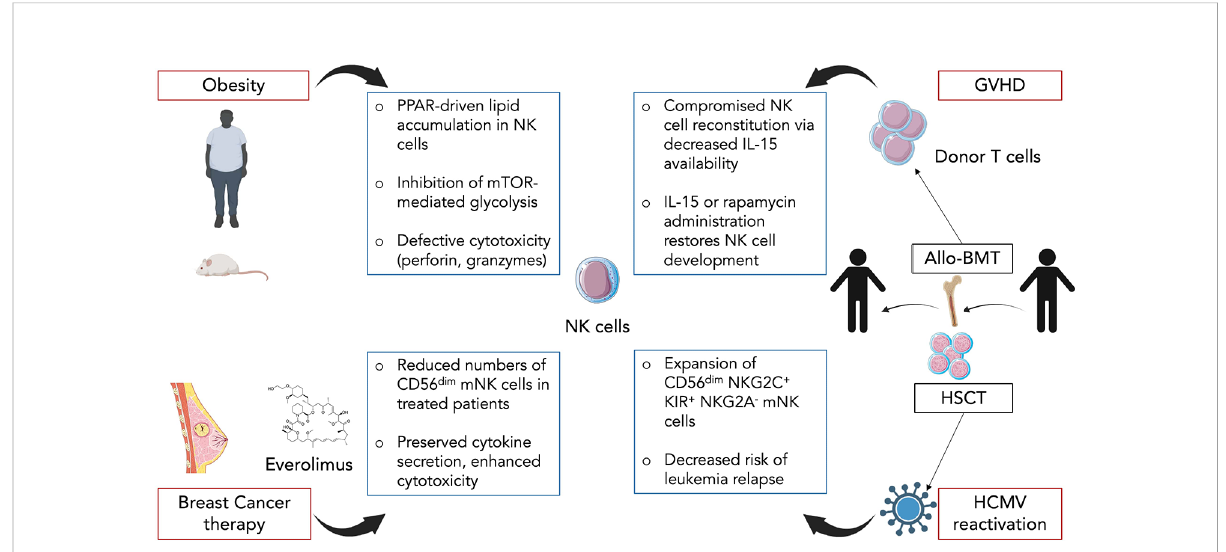
FIGURE 3 Impact of diverse in fl ammatory contexts on NK cell maturation and functional response. In obesity, circulating NK cells accumulate lipid droplets through a PPAR-driven mechanism. This directly promotes an inhibition of mTOR-mediated glycolysis as well as decreased cytotoxic capacity. In breast cancer therapy, mTOR inhibitor everolimus is commonly used and induces changes in NK cells. Treated patients display reduced numbers of CD56 dim mNK cells but the remaining cells exhibit preserved cytokine secretion along with enhanced target cell killing. In graft-versus-host-disease (GVHD) following allogeneic BM transplantation (Allo-BMT), donor T cells compete with NK cells for IL-15 resulting in a compromised NK cell reconstitution. Administration of exogenous IL-15 or rapamycin helps restore NK cell development. In hematopoietic stem cell transplant (HSCT) recipients, human cytomegalovirus (HCMV) reactivation promotes expansion of mature CD56 dim NKG2C + KIR + NKG2A - NK cells. HCMV reactivation also correlates with decreased risk of leukemia relapse which could be linked to the functional status of NK